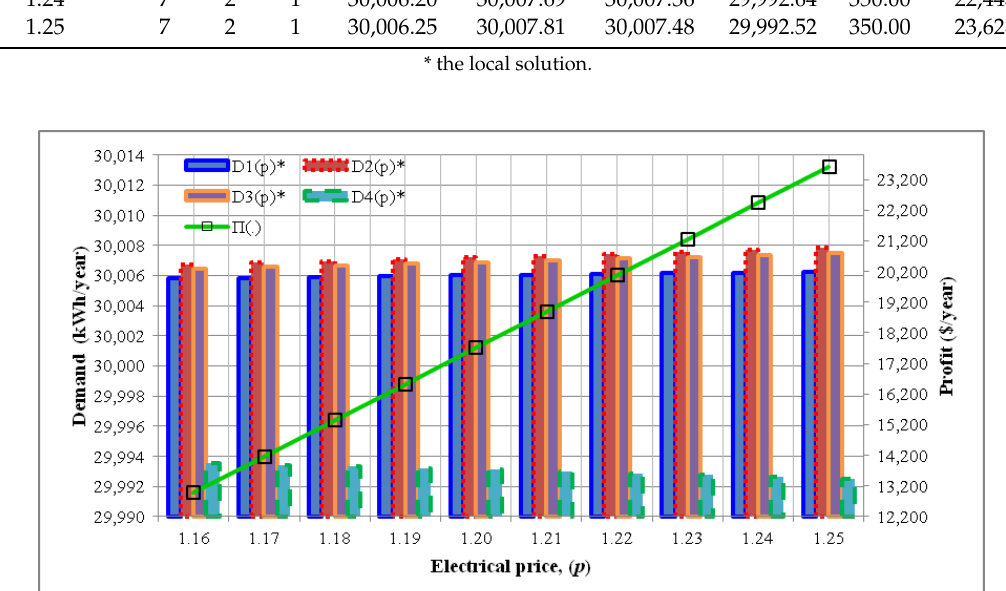
Figure 4. The Effect of Changes in the Price of Electricity on Profitand Demand.